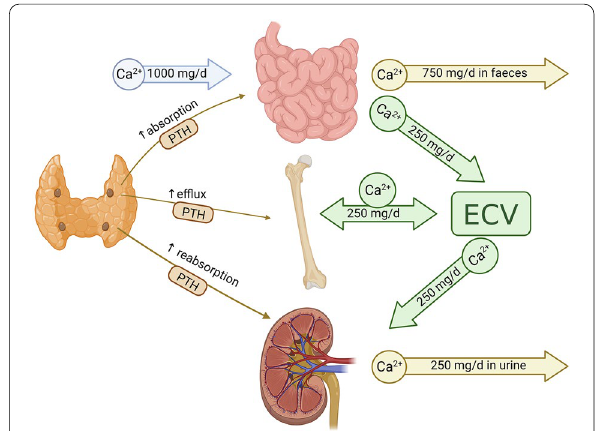
Fig. 1 The basics of calcium homeostasis. Mg/d milligram per day, PTH Parathyroid hormone, ECV extracellular